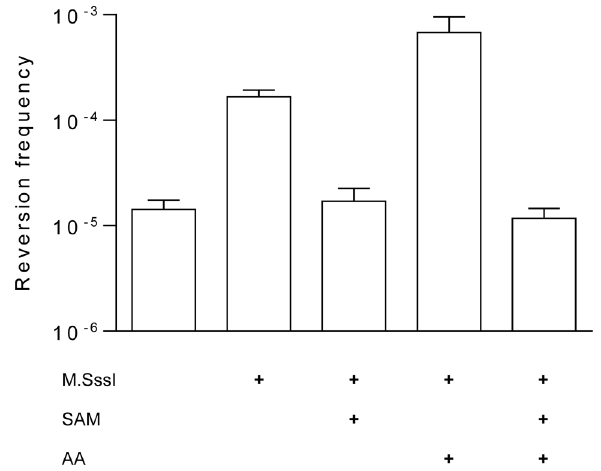
Figure 1. Cytosine deamination by M.SssI in vitro . pUP41 (Ap R , Kn S ) plasmid DNA was incubated with or without wild- type M.SssI (2-fold molar excess relative to CG sites) at 30°C for 4 h, and frequency of C-to-U deamination was determined by scoring the numbers of Kn R and Ap R transformants in E. coli ER2357 ung strain. SAM (160 µM) and 5’-amino-5’- deoxyadenosine (AA, 250 μM) were added to samples as indicated. Error bars represent standard error of the mean of at least three independent experiments